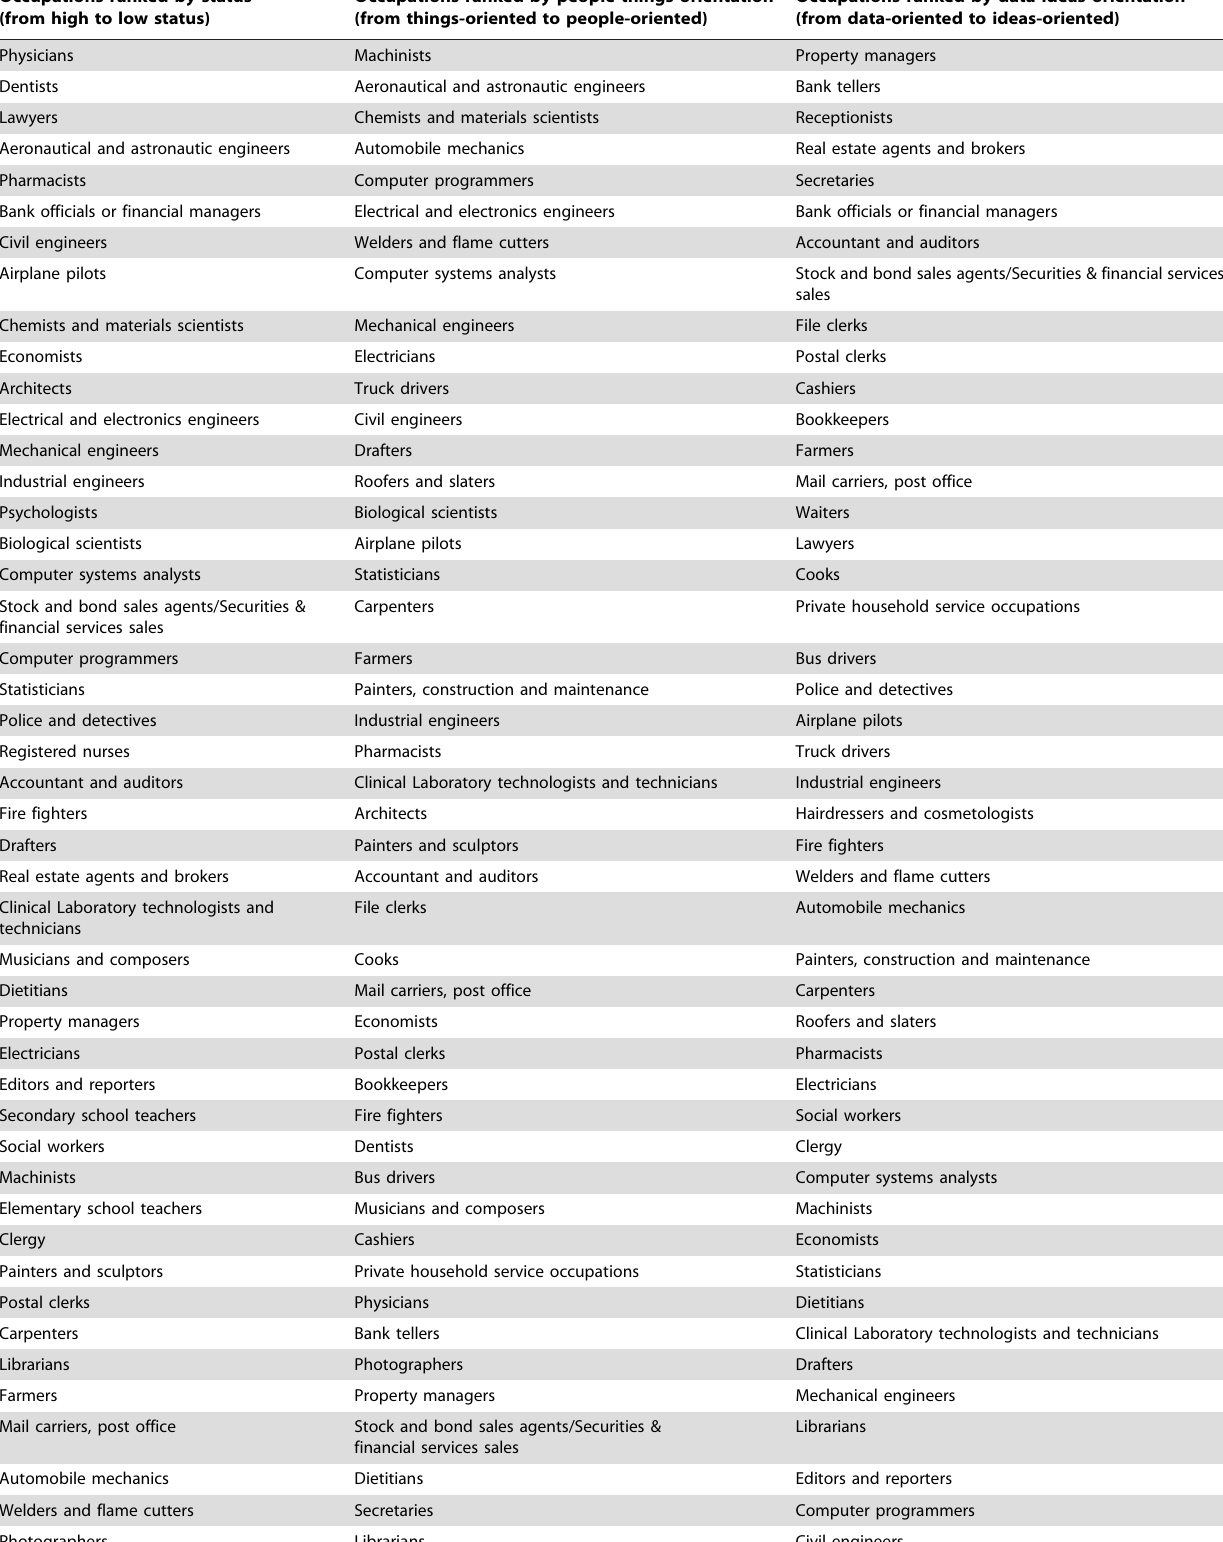
Occupations ranked by status (from high to low